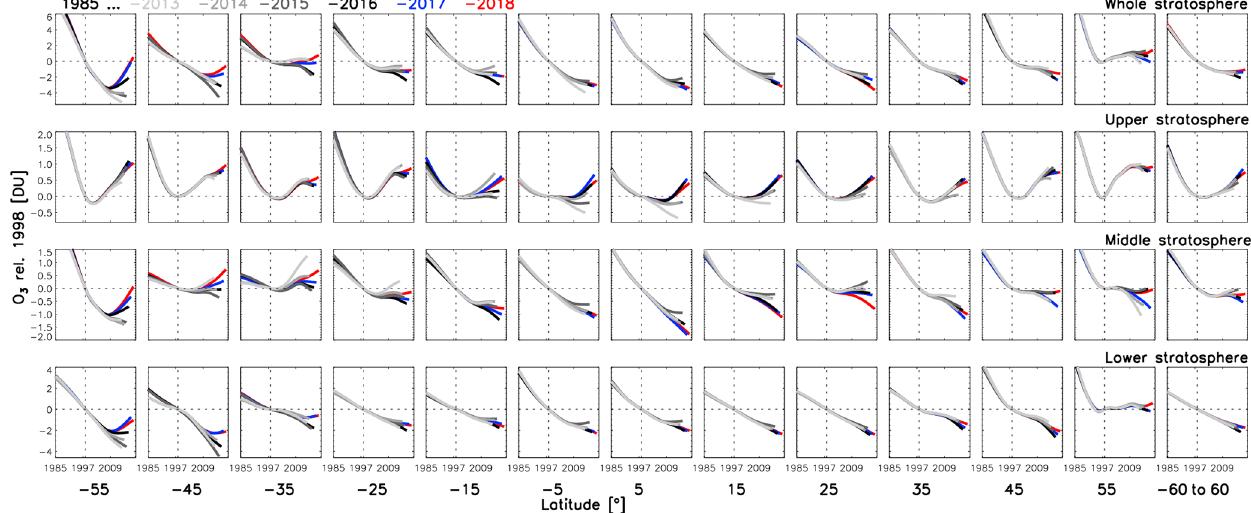
Figure 5. The partial column ozone non-linear trends estimated as a function of end year (2013 to 2018; dark to light colours), for each 10 ◦ latitude and quasi-global (left to right) and the whole, upper, middle, and lower stratosphere (top to bottom). Each sub-panel covers 1985–2018 and all curves are bias corrected to January 1998 (horizontal and vertical dotted lines). Uncertainties for each 1998 to end-year change are given in Fig. 6.